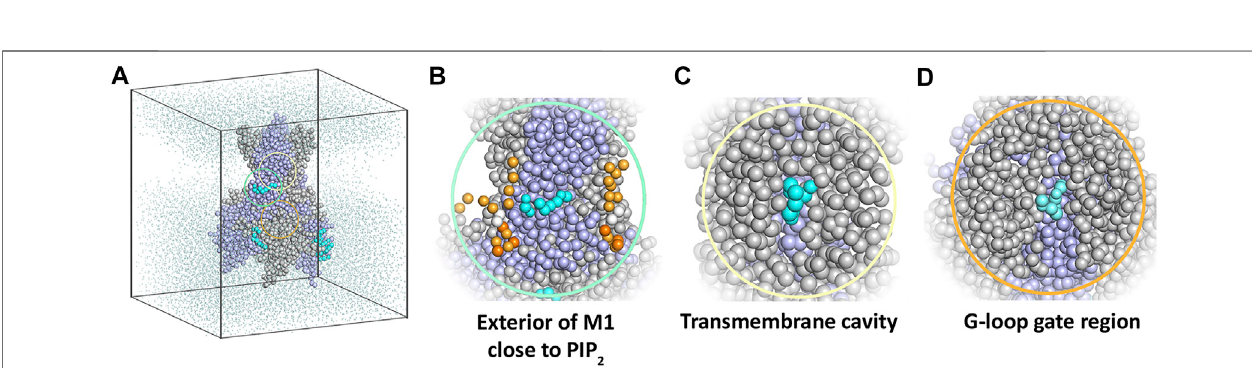
FIGURE 4 | Coarse-grained MD simulation with the K IR 6.2 channel pore and betaxolol. (A) Overview of a typical simulation system after 1 µs simulation. Different subunitsoftheK IR 6.2channelareshown asgreyand lilacspheres,respectively.Boundbetaxololmoleculesareshown ascyanspheres.Watermoleculesareillustrated asdots,whilelipidmoleculesareomittedforclarity. (B) Close-upoftheexteriorofM1,whereabetaxololmoleculeisboundnearthePIP 2 bindingsite.PIP 2 moleculesare shown as orange spheres. (C) Close-up of the transmembrane cavity. (D) Close-up of the G-loop region.